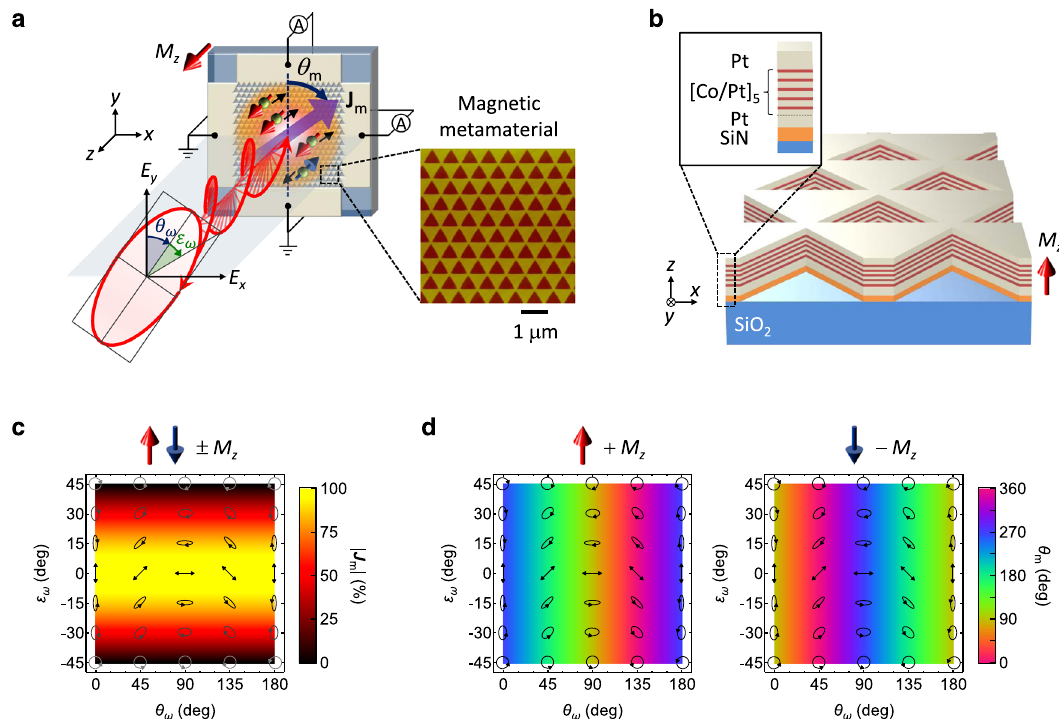
Fig. 1 | Polarization-controlled tunable directional spin-driven photocurrents inamagneticmetamaterial.a